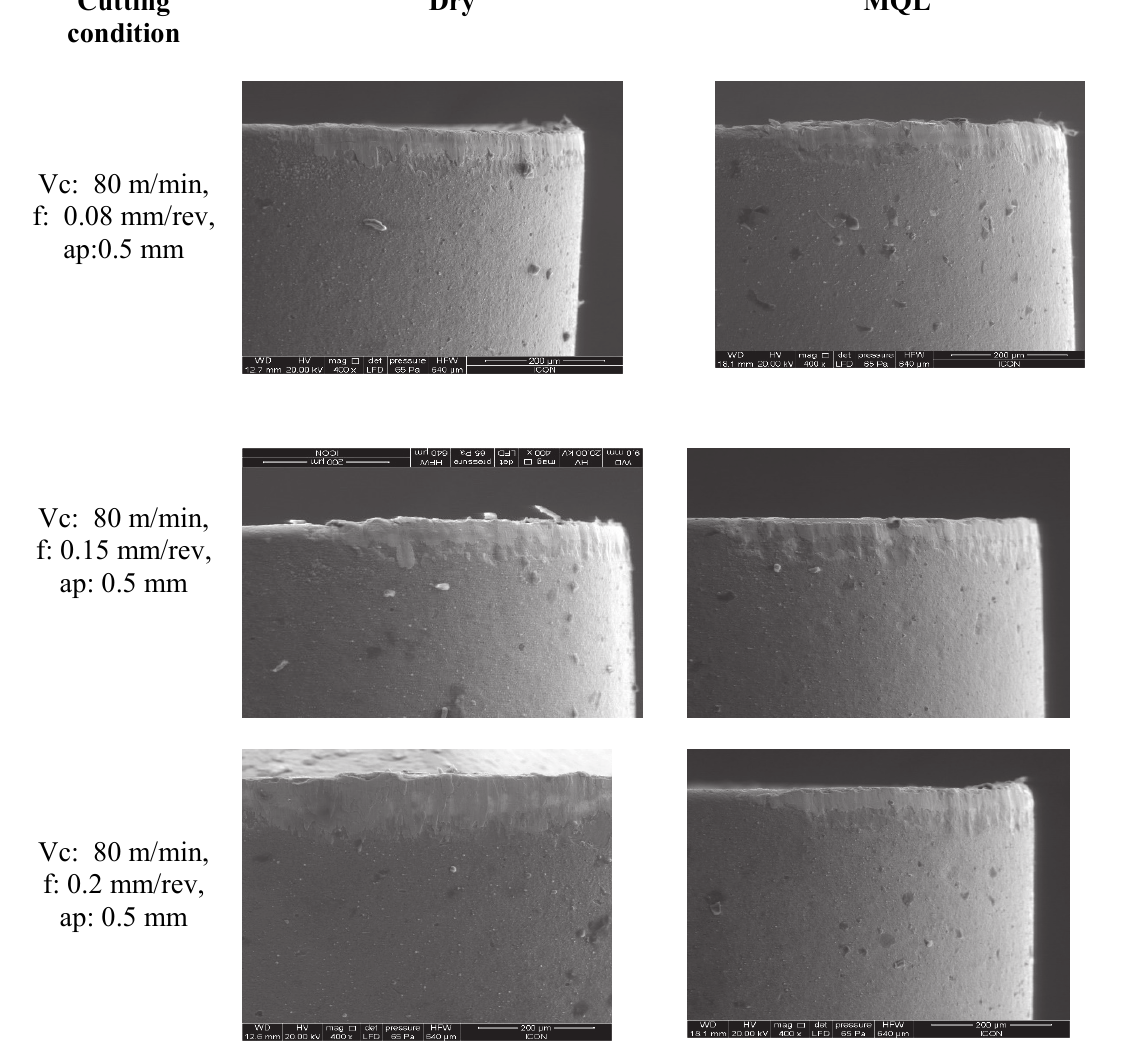
Fig. 16. SEM images of tool wear pattern for PVD TiAlN coated